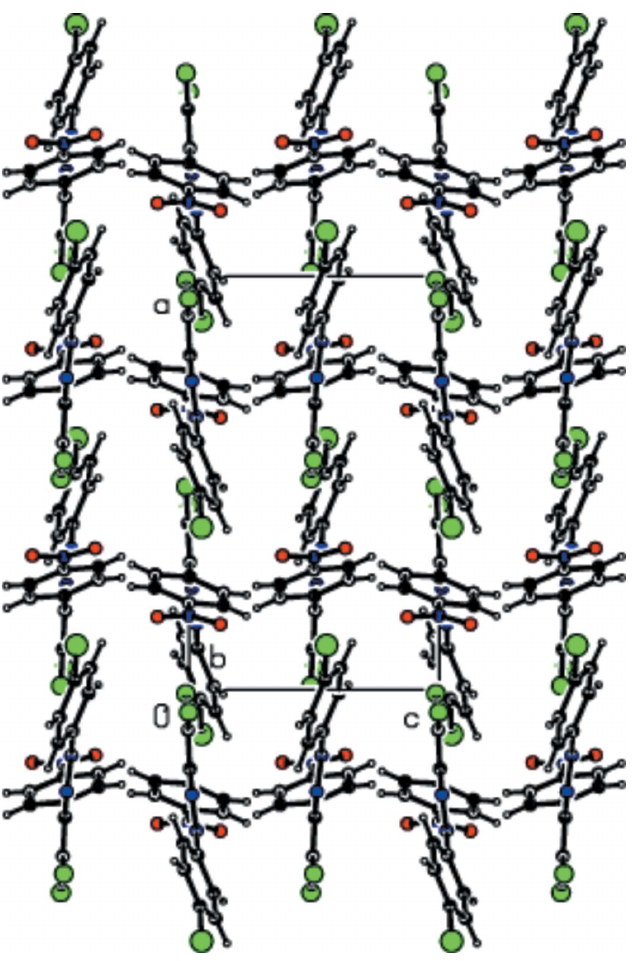
Figure 5 Formation of sheets in (II) parallel to ab through C—Cl (cid:3)(cid:3)(cid:3) (cid:2)